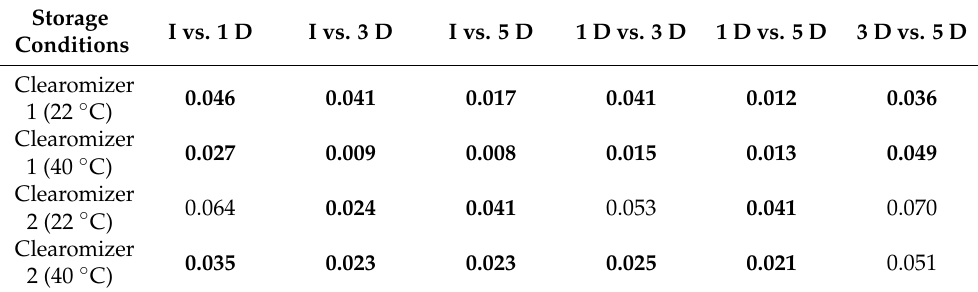
Table 7. The influence of the duration of storage on Zn concentration; p -value for the paired t -test ( t -test: Paired Two Sample for